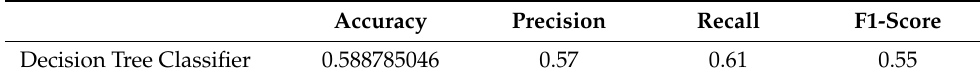
Table 3. Analysis of Decision Tree.